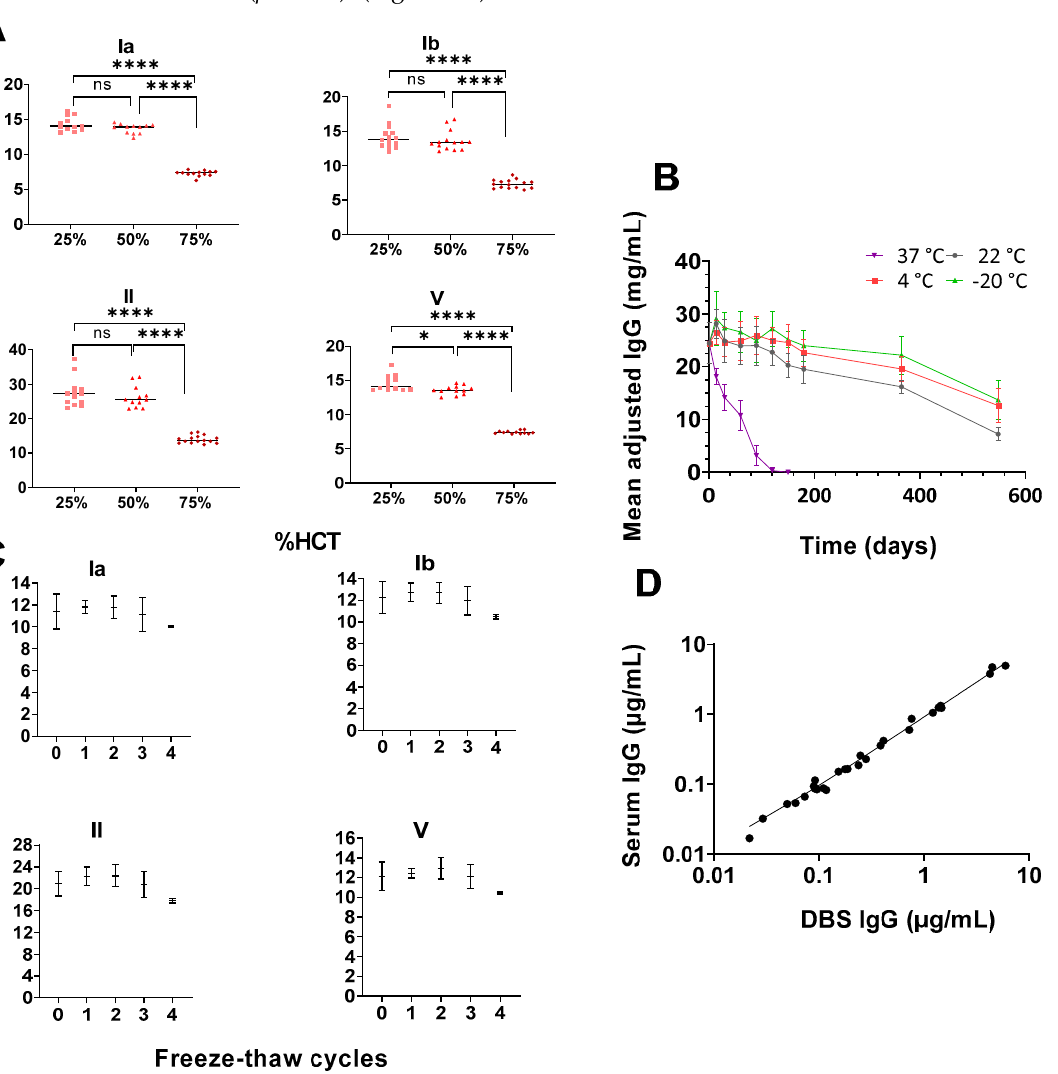
Figure 1. ( A – D ). ( A ): Serotype-specific (Ia, Ib, II and V) IgG concentrations ( µ g/mL) with haematocrit levels of 25%, 50%, and 75%. * p = 0.010, **** p ≤ 0.0001. ( B ): The stability of the mean-adjusted total IgG levels in DBS stored at different temperatures over 18 months (mean ± S.D). ( C ): Median and interquartile range of serotype specific IgG levels (ug/mL) (Ia, Ib, II, and V) in eluates taken from laboratory-prepared DBS after 0–4 freeze thaw cycles. ( D ): Correlation between paired laboratory spiked DBS and serum samples ( n = 18). For simplicity, serotypes III and IV are not shown; however, the serotypes included in the figure are illustrative of the general trend. 3.3. Storage Temperatures Affect Antibody Stability There were marked declines in total IgG antibody concentrations at all temperatures above 4 °C within the first three months ( p < 0.01) (Figure 1B). Compared with the baseline,